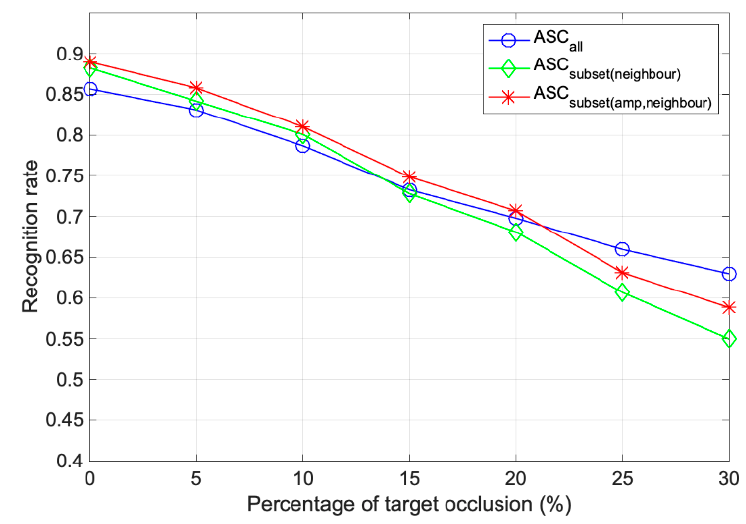
Figure 11. Performance comparison of different subsets by the degree of partial occlusion.